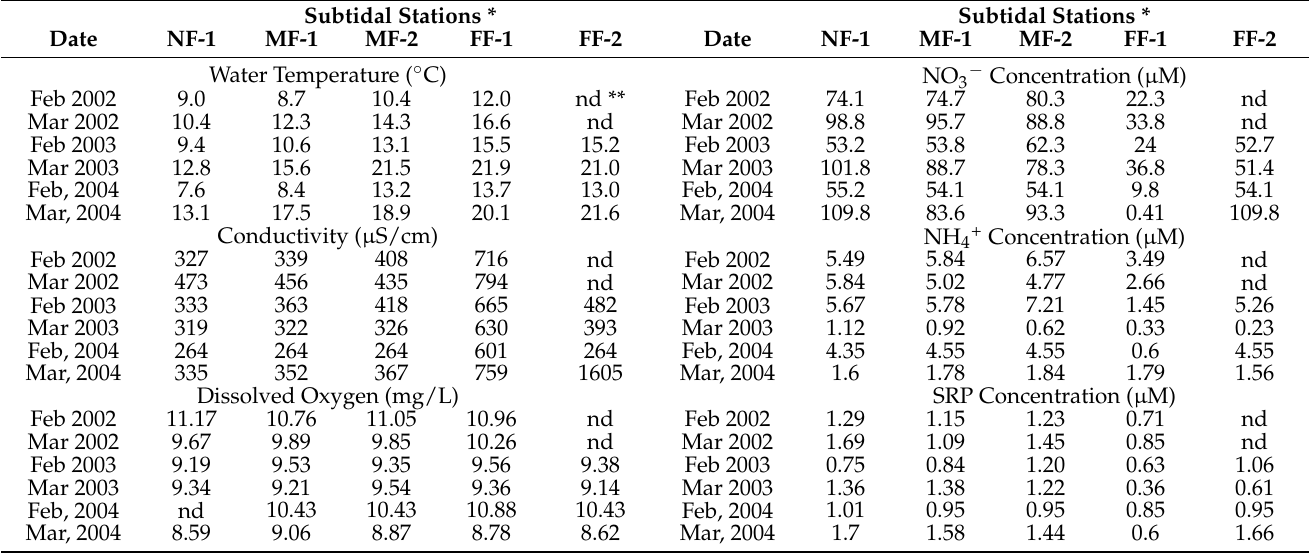
Table 1. Physical and chemical characteristics of ambient overlying water in the five stations studied during six pulse experiments.